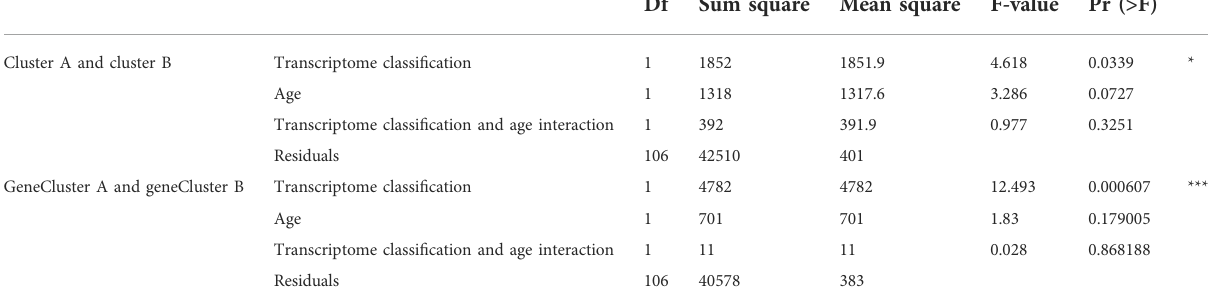
TABLE 2 The analysis of variance for the transcriptome classi fi cation, age, and their interaction. Df Sum square Mean square F-value Pr